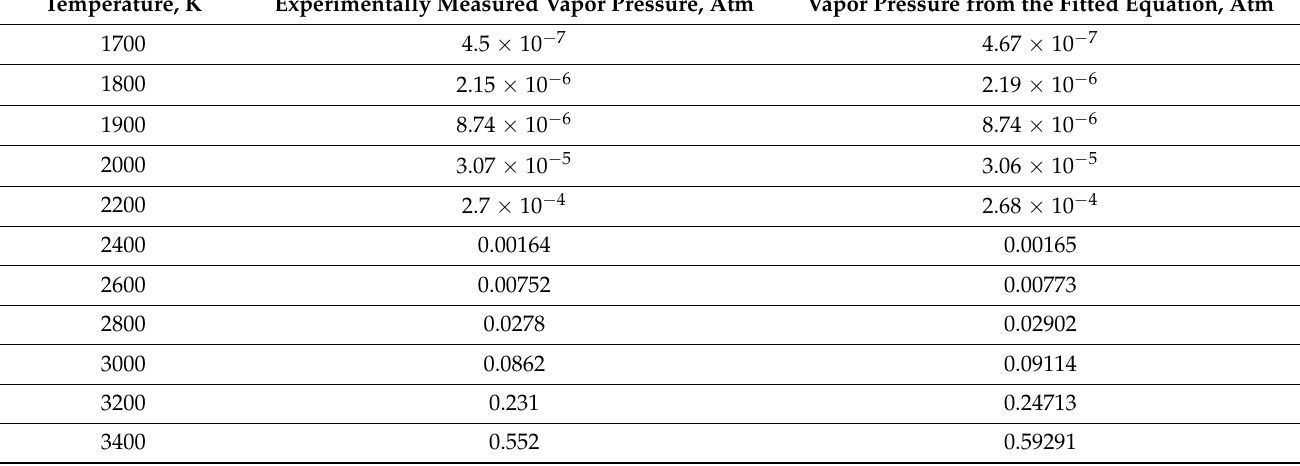
Table A1. Comparison between the experimental data [12] and the fitting results in Figure 2 between 1700 K and 3400